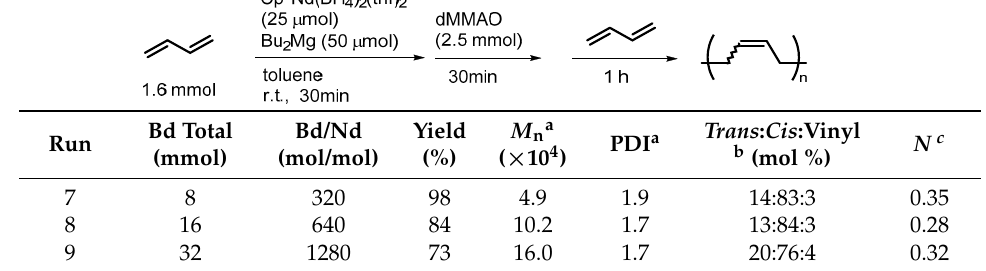
Table 2. Effect of initial monomer feed on the molecular weight in the butadiene polymerization using the Cp*Nd(BH 4 ) 2 (thf) 2 –Mg/Al catalyst system.